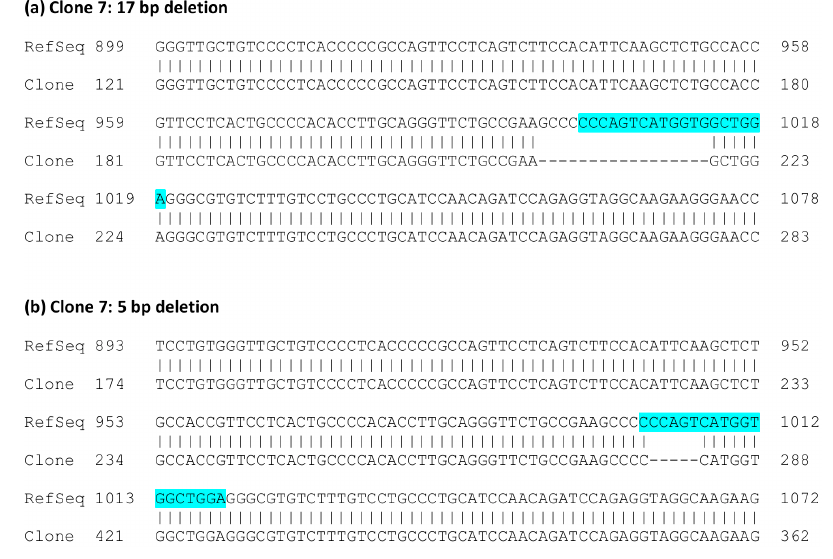
Figure 4. Sequence analysis of the genomic DNA of FLOT1 knockout clone 7. A genomic region of 570 bp comprising exon 3 and the flanking intronic regions was PCR amplified, cloned into a vector, and six plasmid clones were sequenced. The numbering of the reference sequence (upper row) corresponds to the human FLOT1 reference gene sequence (NC_000006.12, region 30.727.709-30.742.851, complementary strand). The gRNA sequence is highlighted in light blue. ( a ) Clones containing the 17 bp deletion; ( b ) clones containing the 5 bp deletion.